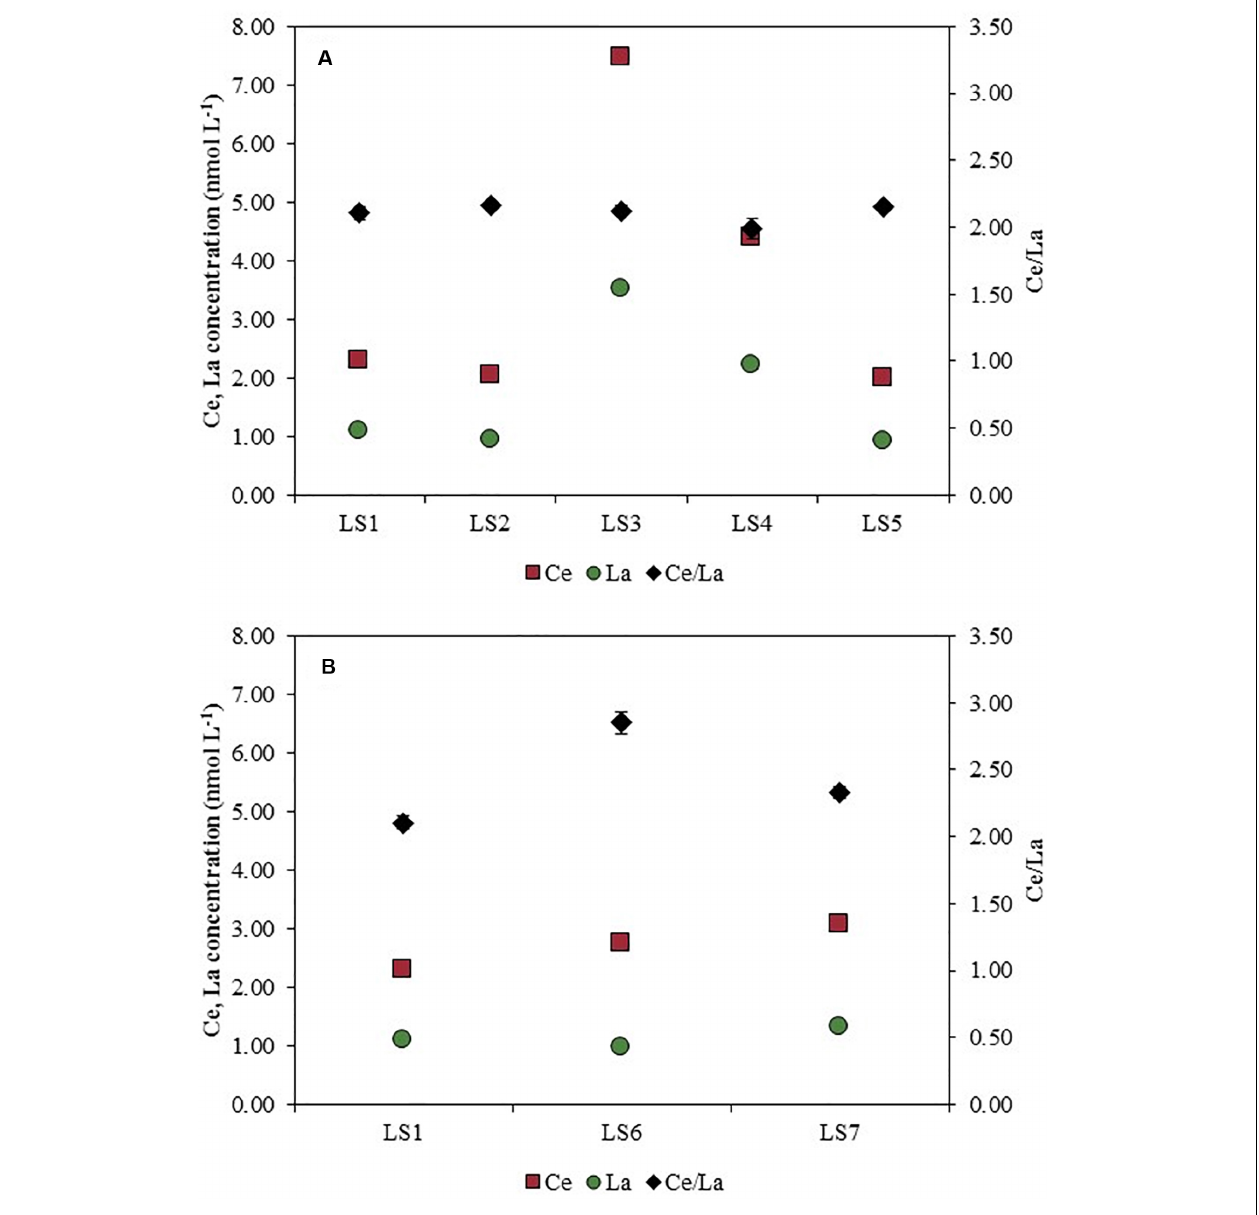
sampling site), with equivalent size for spherical distributions from 80 nm to 200 nm and from 200 nm to 500